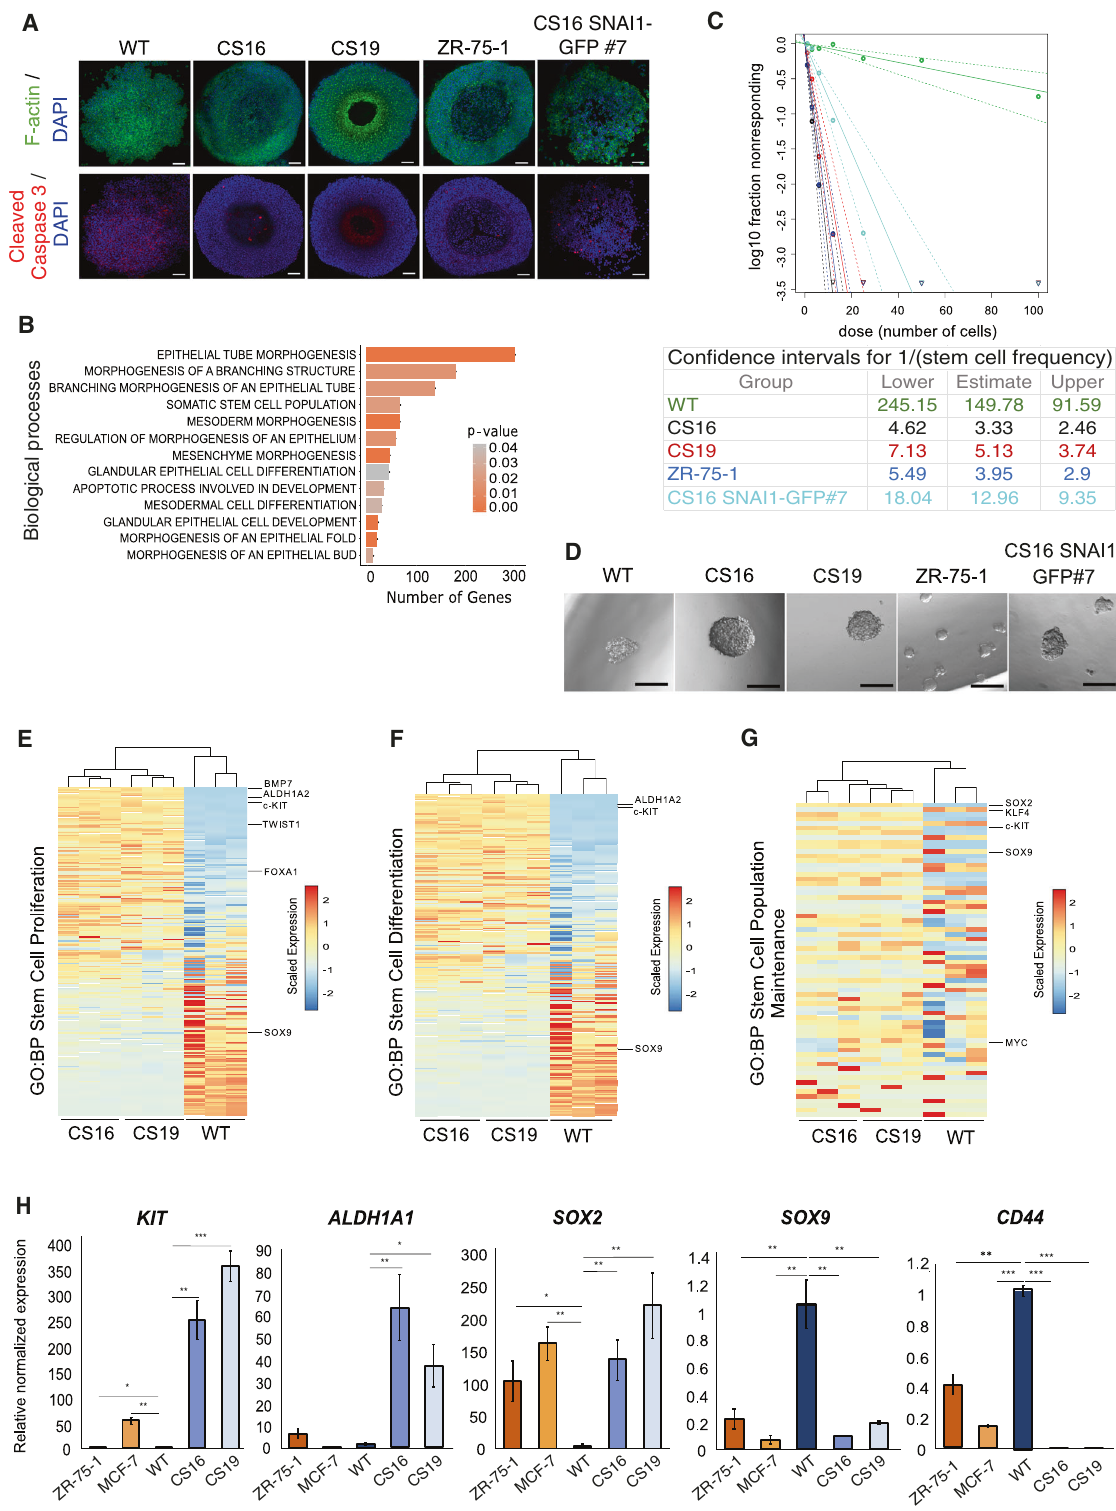
line with this, mRNA and protein analyses revealed a notable increase in the levels of FOXA1 in SNAI1 -KO cells compared to WT, while ZR-75-1 and MCF-7 luminal cells presented the highest expression (Fig. 6D, E). Stable SNAI1 overexpression in CS16 SNAI1 - KO ( SNAI1 -GFP#7) cells reversed, but only slightly, the